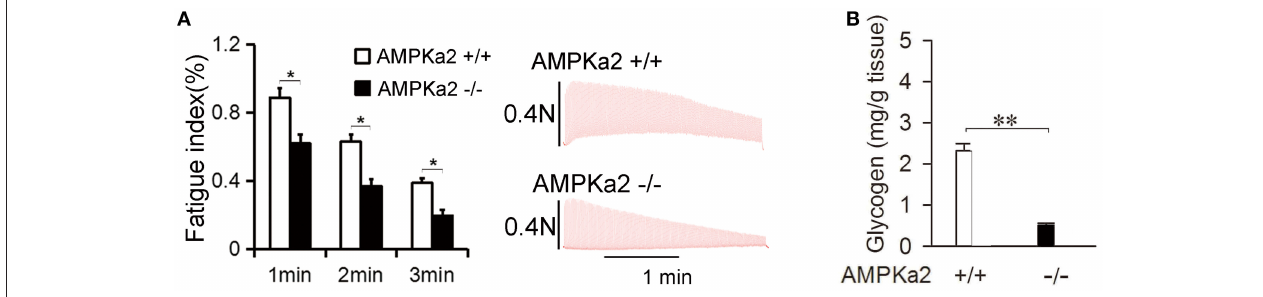
FIGURE 1 | Mice deficient in AMPK α 2 have reduced muscle endurance and glycogen synthesis. (A) Representative records of electrically evoked contractions of soleus muscle isolated from AMPK α 2 + / + ( n = 6) and AMPK α 2 − / − mice ( n = 6) for consecutive 3min. Data are expressed as the mean ± s.d. * P < 0.05 by Student’s t -test. (B) Soleus muscle glycogen contents in AMPK α 2 + / + ( n = 6) and AMPK α 2 − / − mice ( n = 6). Data are expressed as the mean ± s.d. ** P < 0.01 by Student’s t -test.